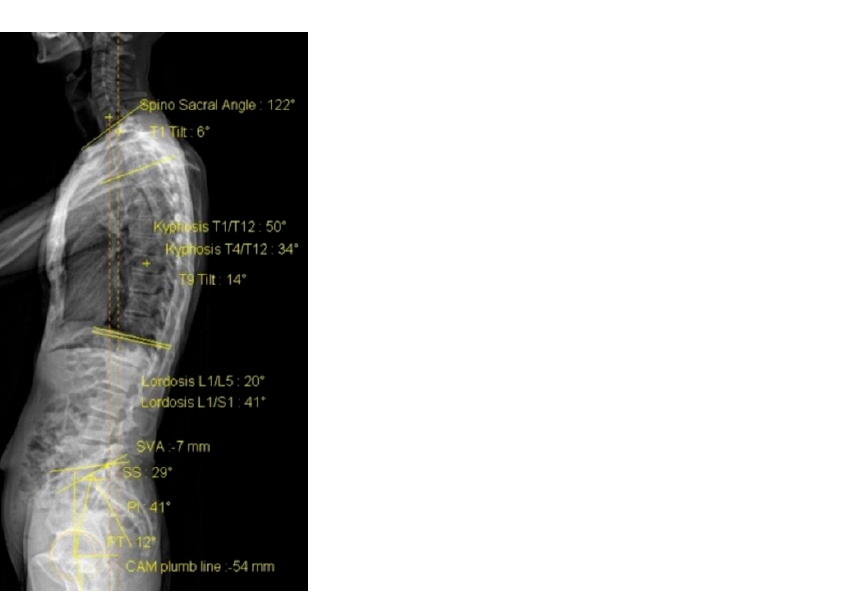
Figure 3. EOS imaging. PI: pelvic indigence; SS: sacral slope; PT: pelvic tilt; SVA: sagittal vertical axis; CAM: center of the acoustic meatus.